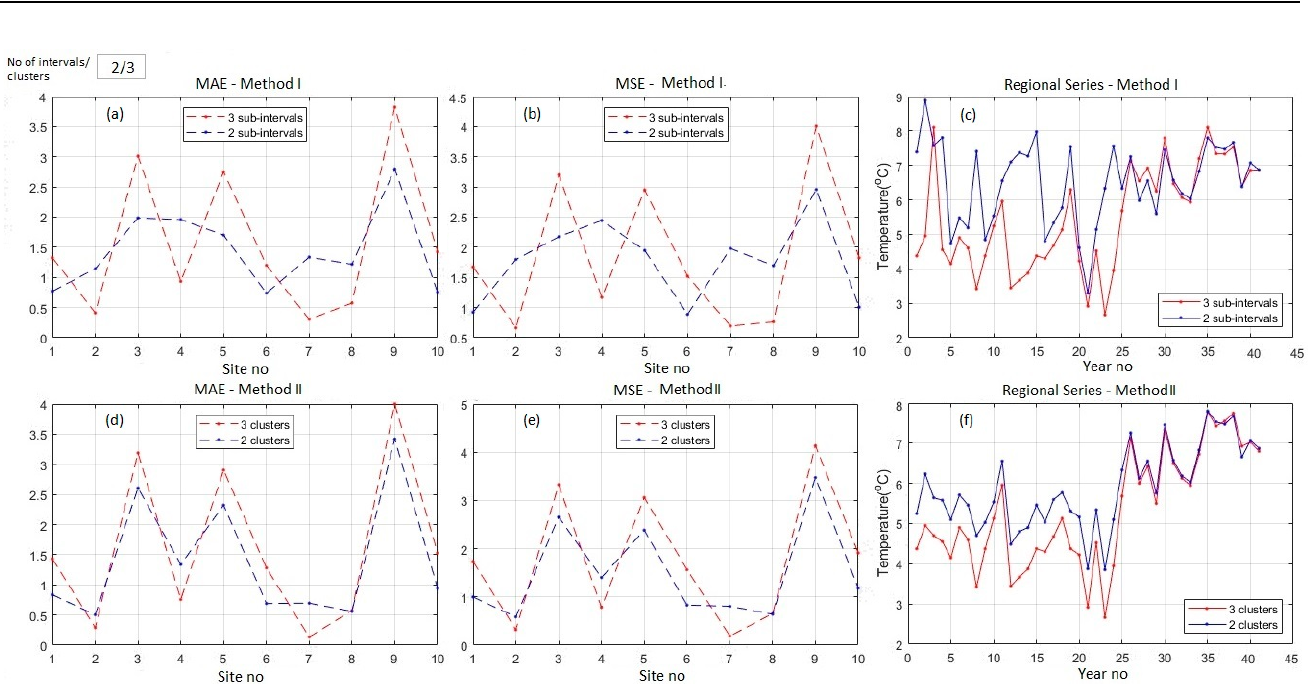
Figure 6. Comparison between the results on the minimum temperatures for two and three